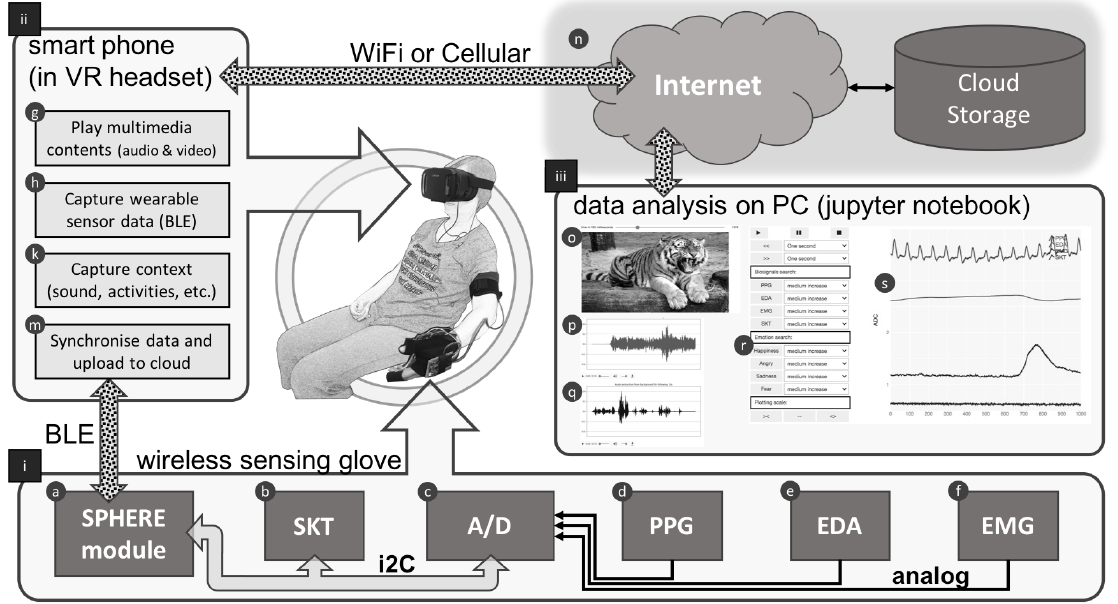
Figure 2. Block diagram of emotionWear emotion recognition framework. SPHERE, Sensor Platform for HEalthcare in a Residential